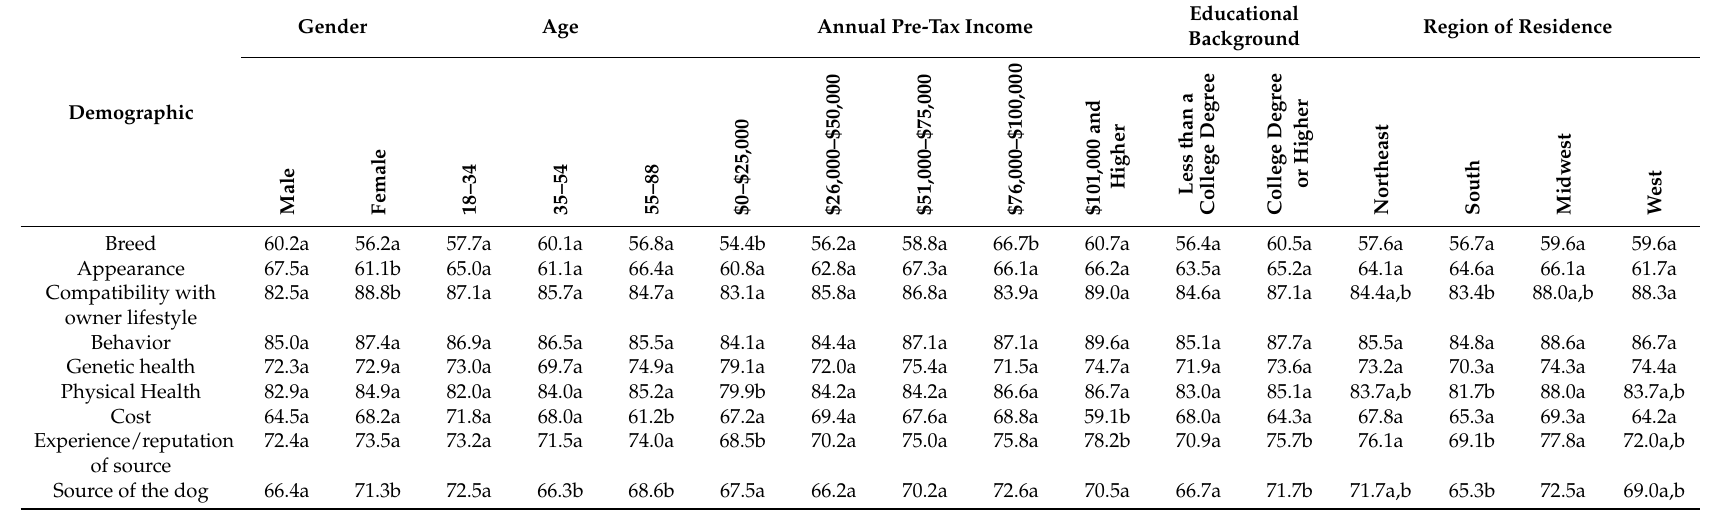
Table 5. Cross-tabulations “Characteristics you believe are most important in acquiring a dog” (% of respondents; n = 507).